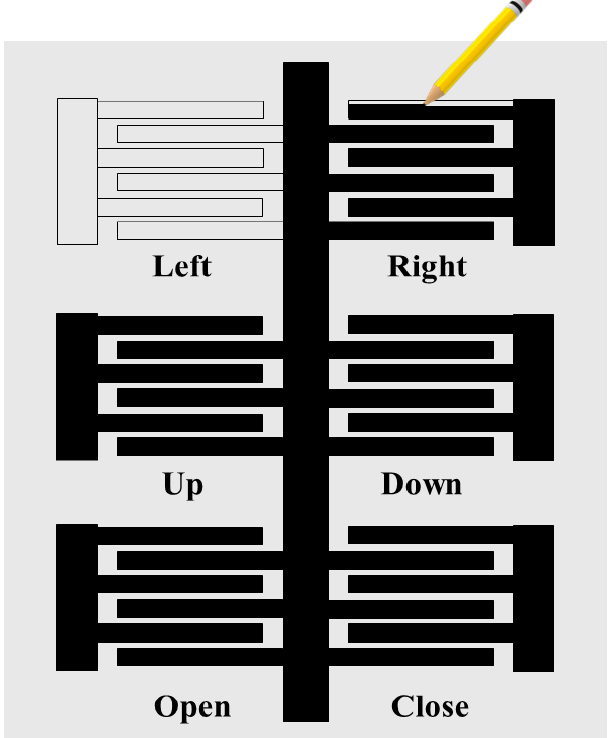
Figure 1. GOP-based fabrication process to fabricate the CPS touch keypad-based HMI.